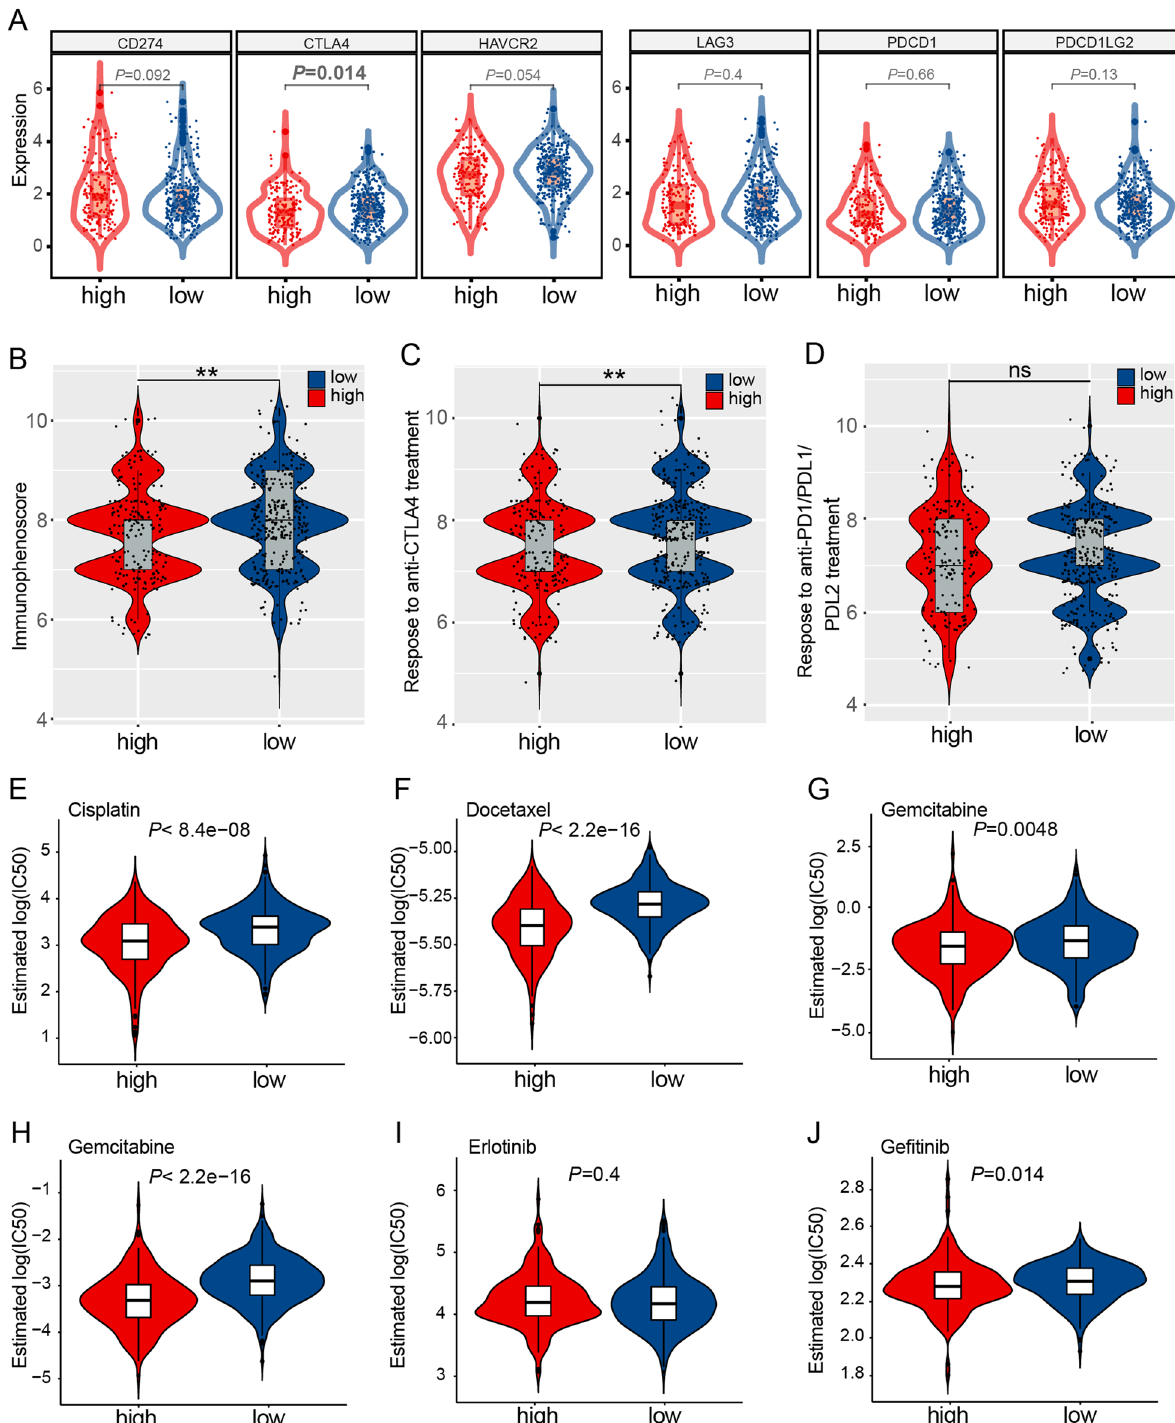
Fig. 4 The risk signature predicted response to common antitumor drugs in the TCGA-LUAD cohort. A Comparison of immune checkpoint gene expression between the high- and low-risk groups. B – D Calculation of the immunophenoscore B and the sensitivity to anti-CTLA4 C and anti-PD1/ PDL1/PDL2 D immunotherapy for the two subgroups. E – J . Half inhibitory concentrations (IC50) were compared between high- and low-risk groups for cisplatin ( E ), docetaxel ( F ), gemcitabine ( G ), paclitaxel ( H ), erlotinib ( I ), and gefitinib ( J